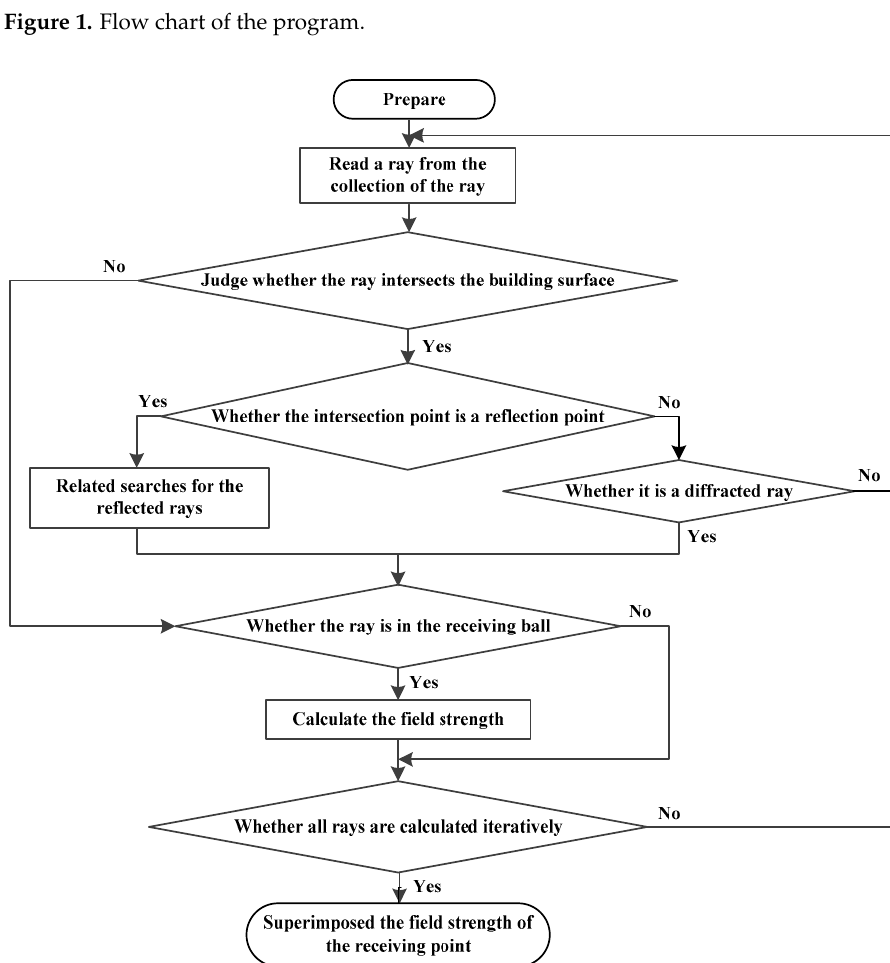
Figure 2. Detailed flow chart of the program.